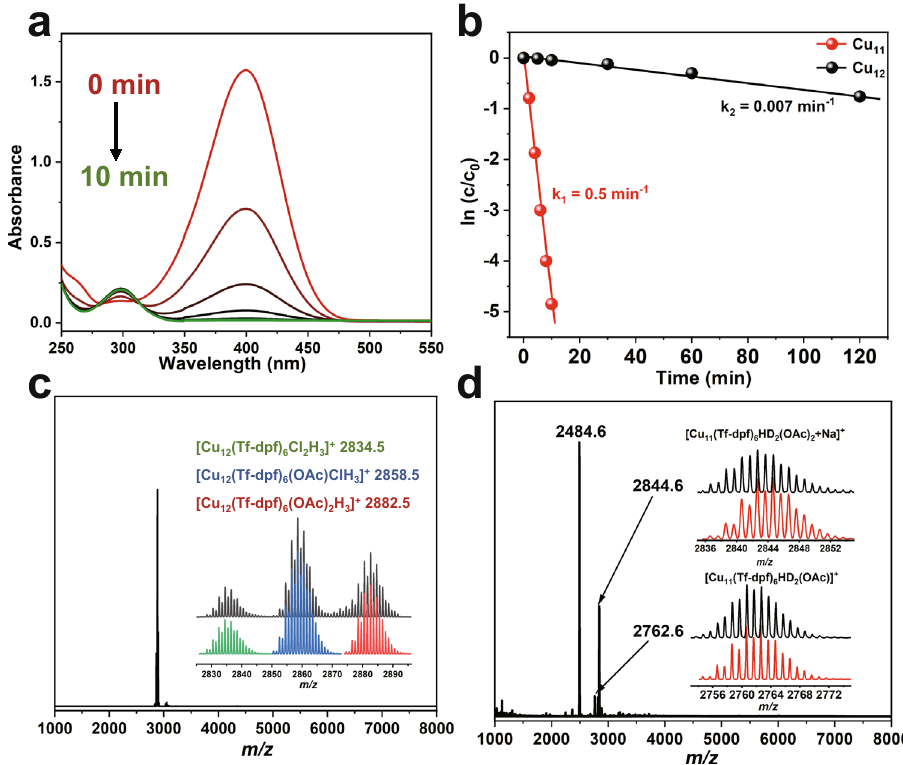
Fig. 7 Catalytic performance of Cu 11 and Cu 12 . a UV – Vis spectra showing gradual reduction of 4-NP catalyzed by Cu 11 . b Plot of − ln(c/c 0 ) vs. reaction time during the reduction of 4-NP with Cu 11 and Cu 12 catalysts. c ESI-MS of Cu 12 after catalysis with NaBD 4 . Inset: the comparison of the measured (black trace) and simulated isotopic distribution patterns of [Cu 12 H 3 (Tf-dpf) 6 Cl 2 ] + (green, 2834.5), [Cu 12 H 3 (Tf-dpf) 6 (OAc)Cl] + (blue, 2858.5), and [Cu 12 H 3 (Tf- dpf) 6 (OAc) 2 ] + (red, 2882.5). d ESI-MS of Cu 11 after catalysis with NaBD 4 . Inset: the comparison of the measured (black trace) and simulated (red